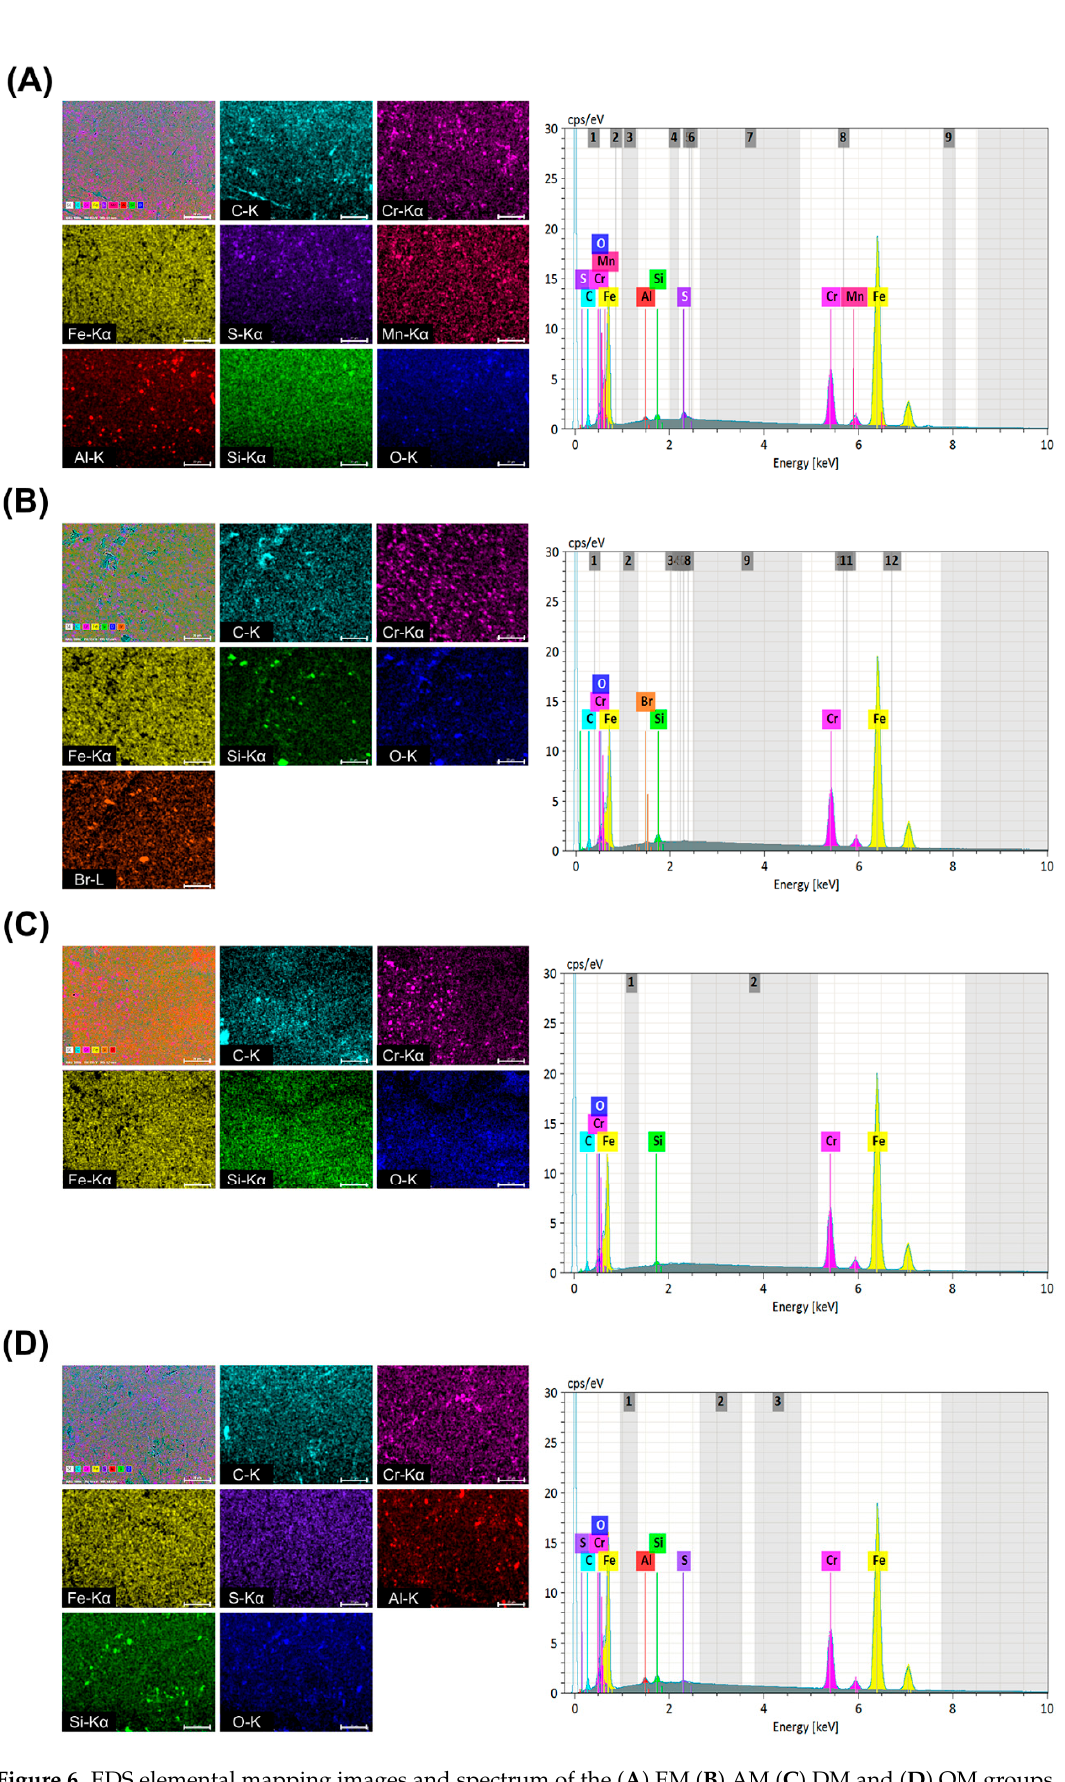
Figure 6. EDS elemental mapping images and spectrum of the ( A ) EM ( B ) AM ( C ) DM and ( D ) OM groups.